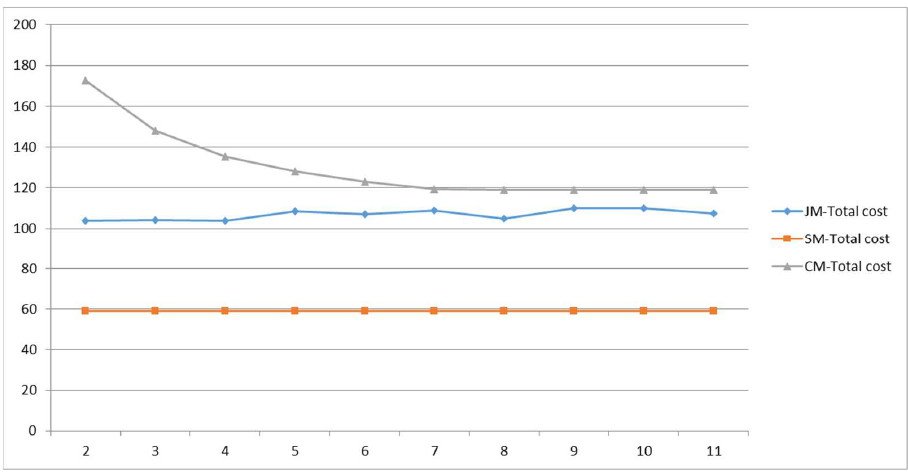
Figure 15. Total cost variations with parameter s .